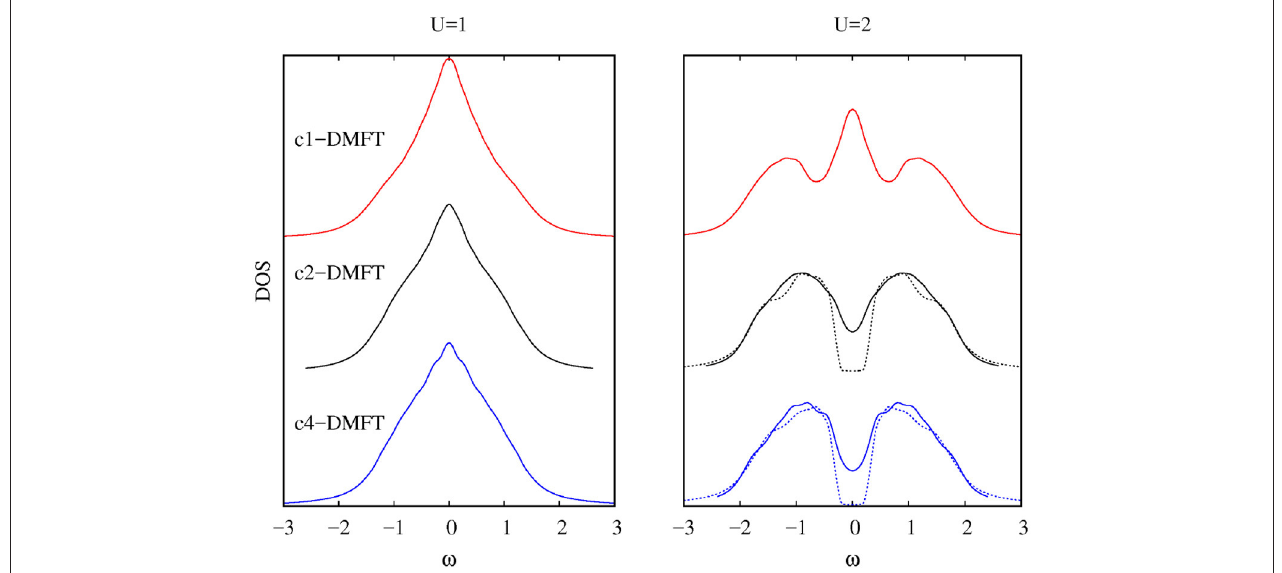
FIGURE 3 | Comparison of the DOS calculated using different cluster sizes for the Hubbard Hamiltonian on the square lattice for two values of U . As in Figure 2 , results for two different values of the broadening η are shown, emphasizing the gap for the insulating regime. The curves are shifted for clarity.